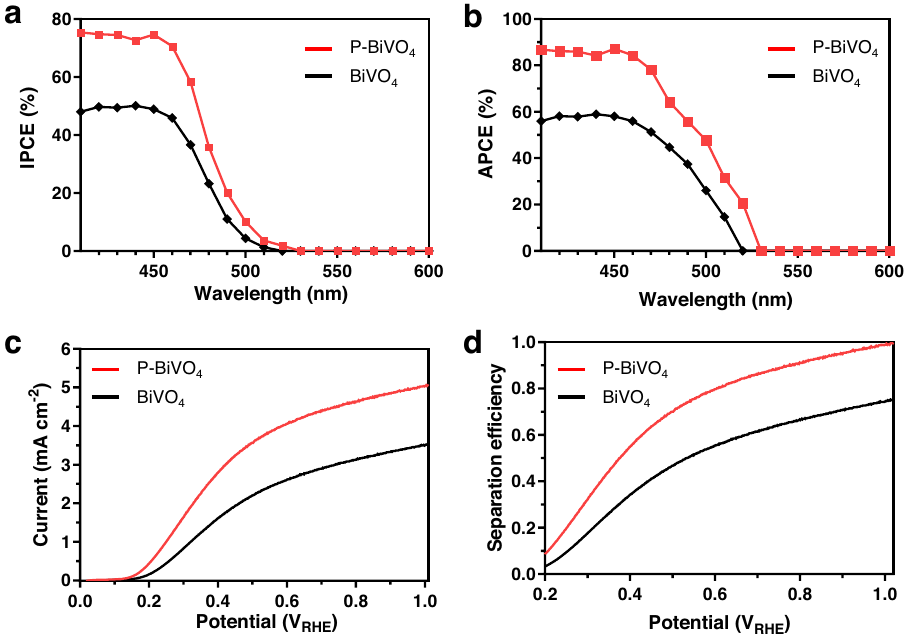
Fig. 3 | Photoelectrochemical performance for sul fi te oxidation. a IPCE curves and b APCEcurvesoftheBiVO 4 andphosphorus-dopedBiVO 4 samplesmeasuredat 0.6 V RHE . c Current density-voltage curves of the BiVO 4 and phosphorus-doped